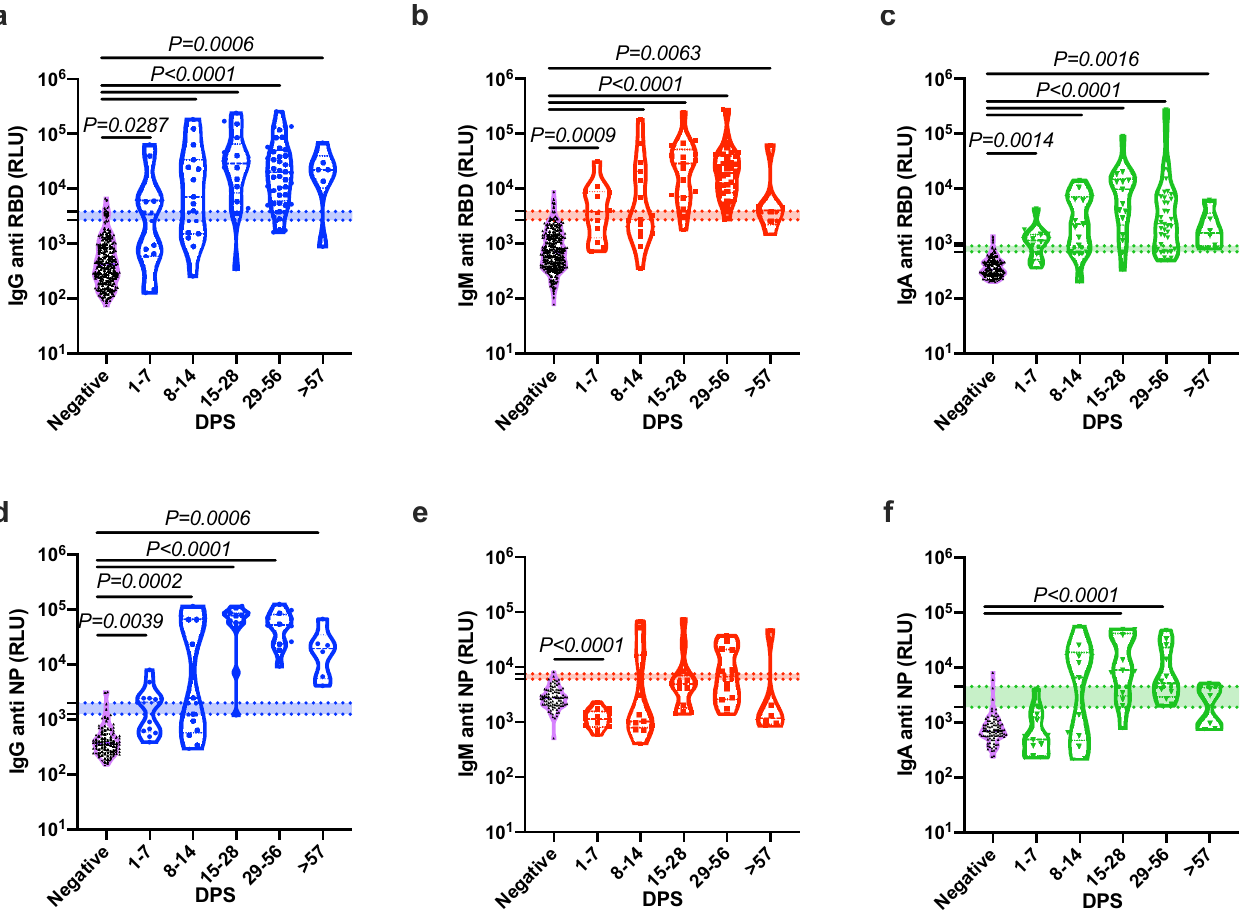
Figure 2. Comparison of the development anti-SARS-CoV-2 RBD and NP antibodies. Peripheral blood was collected from hospitalized COVID-19 and recovered patients. Negative samples were obtained from true SARS-CoV-2 negative patients (i.e., prior to the SARS-CoV-2 pandemic). Plasma was obtained, diluted 1:50, and added to a 96-well plate precoated with SARS-CoV-2 RBD ( a – c ) or NP ( d – f ) antigens. IgG ( a , d ), IgM ( b , e ), and IgA ( c , f ) levels are shown. ( a – f ) Kinetics of all samples. Data were calculated using GraphPad Prism 8; the dotted line represents the calculated cutoff values (95% and 98% sensitivity) discriminating between positive and negative samples. Statistical analysis was performed using a Nonparametric Kruskal–Wells test for multiple